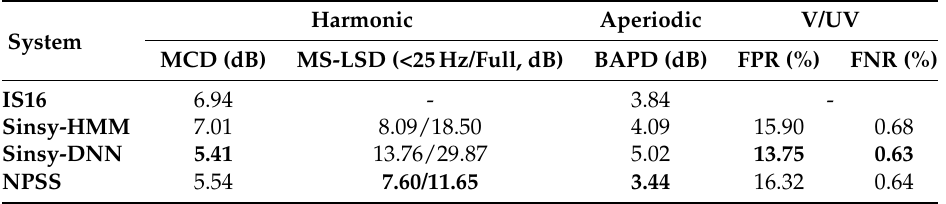
Table 1. Quantitative results for the timbre models trained on natural singing. Note that for the IS16 system the Modulation Spectrum Log Spectral Distortion (MS-LSD) and Voiced/Unvoiced (V/UV) metrics are omitted as it does not use predicted harmonic features (MS-LSD is computed from predicted features, not analyzed features) or V/UV decision. The HTS system is only considered when comparing systems trained on pseudo singing, but should be roughly equivalent to Sinsy-HMM.